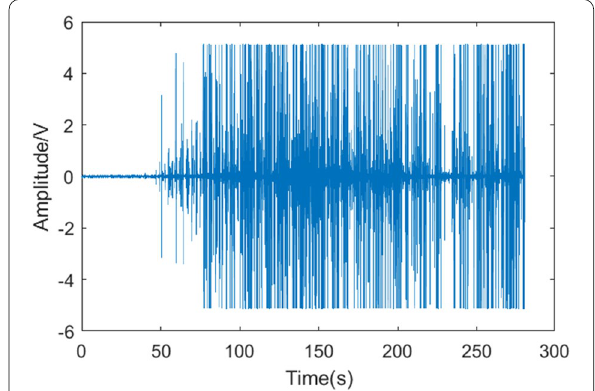
Fig. 11 Original acoustic emission signal of Pinus